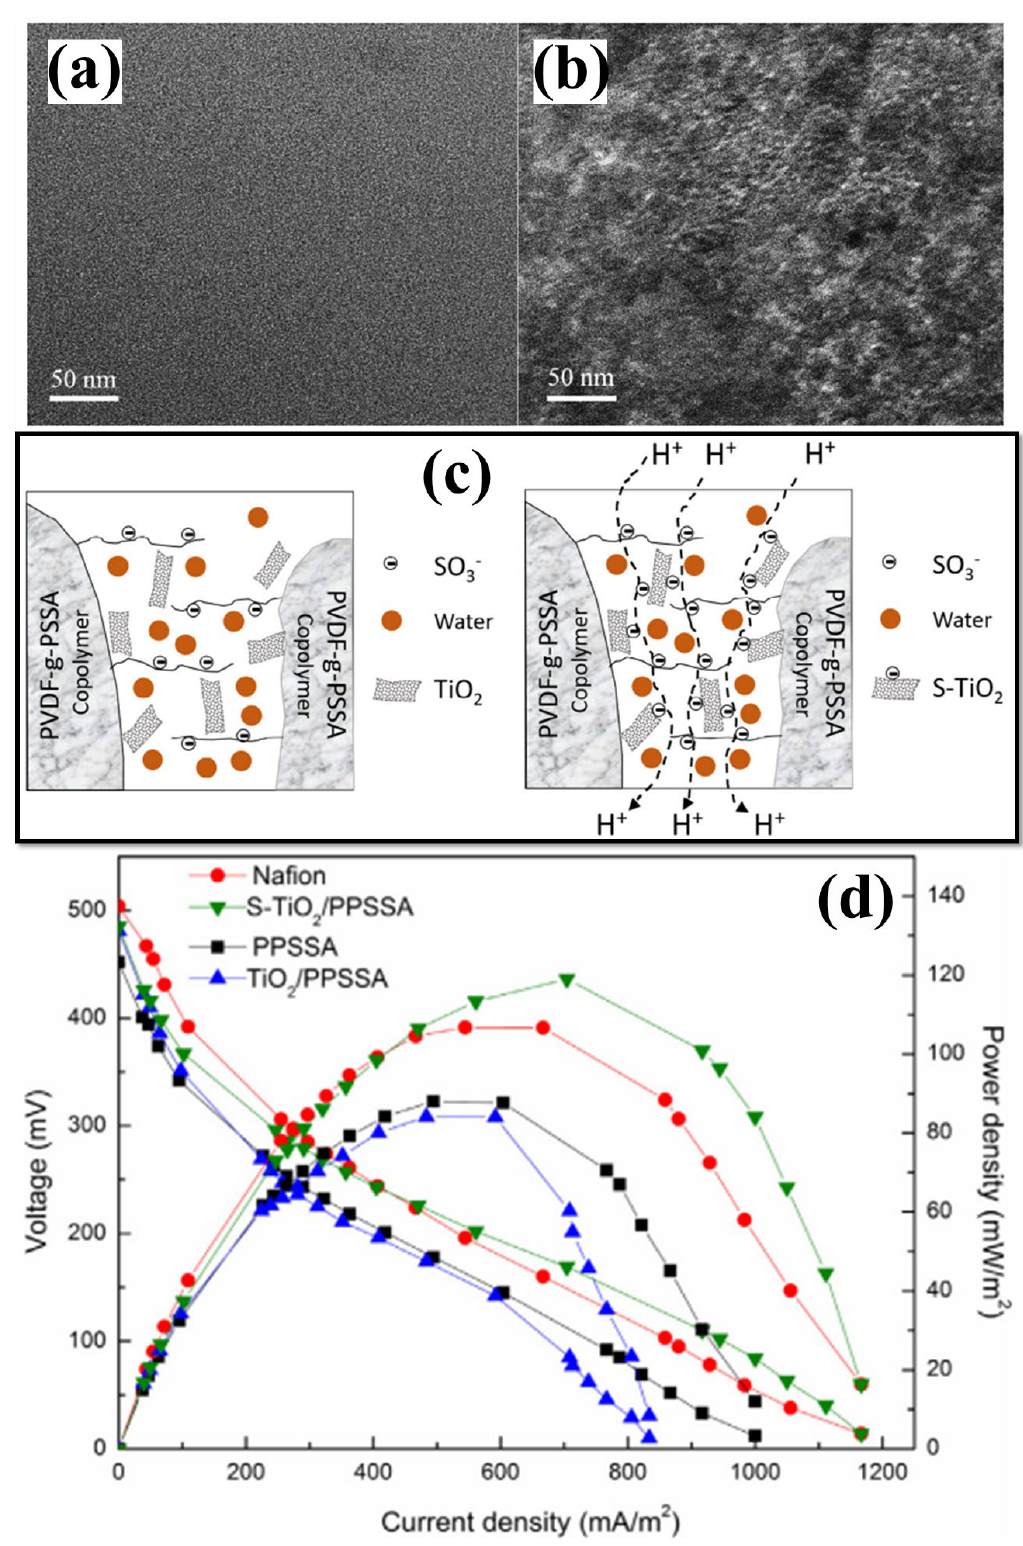
Figure 4. Transmission electron microscope images of ( a ) PPSSA and ( b ) PPSSA-sTiO 2 membranes. ( c ) Diagrammatic representation of the PPSSA-sTiO 2 membranes’ proton transport routes. ( d ) Po- larization and power density curves of Nafion, PPSSA, PPSSA-TiO 2 , and PPSSA-sTiO 2 membranes. Reproduced from [139], with permission from Elsevier, 2019.